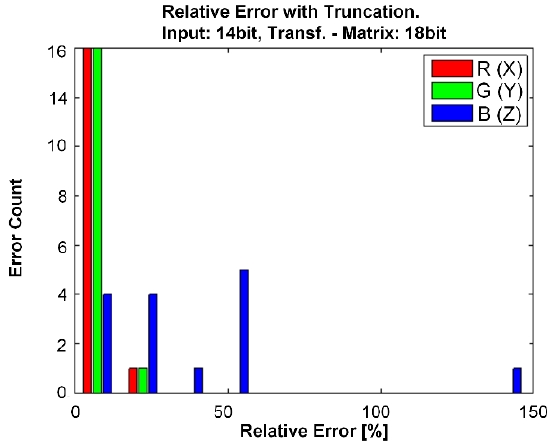
Figure 17. Relative error of X, Y, Z for 15 different light sources and 14-bit